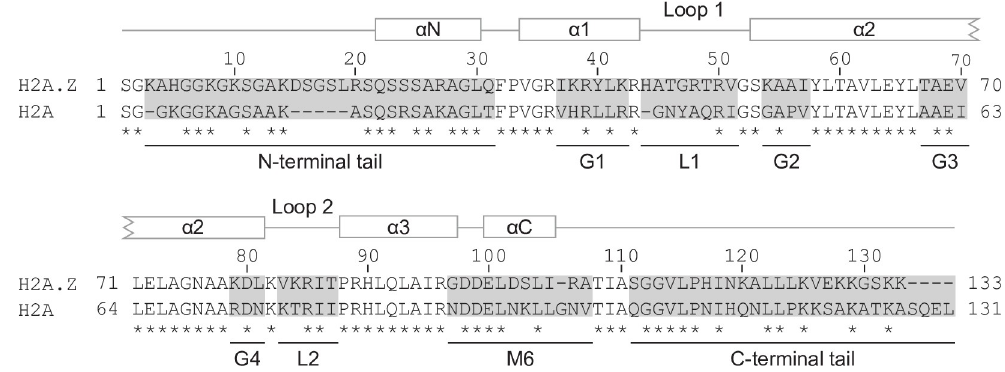
Fig 1. Amio acids that differ between H2A.Z and H2A were grouped into nine distinct regions. Sequence alignment of the S . cerevisiae H2A.Z and H2A proteins with conserved amino acids indicated by asterisks. Regions that differ between H2A.Z and H2A were divided into nine distinct regions: N-terminal tail, C-terminal tail, M6, two histone loops (L1 and L2) and four groups in the histone fold (G1-G4). The H2A.Z secondary structure is shown above the sequence alignment with lines indicating unstructured flexible regions and boxes indicating alpha